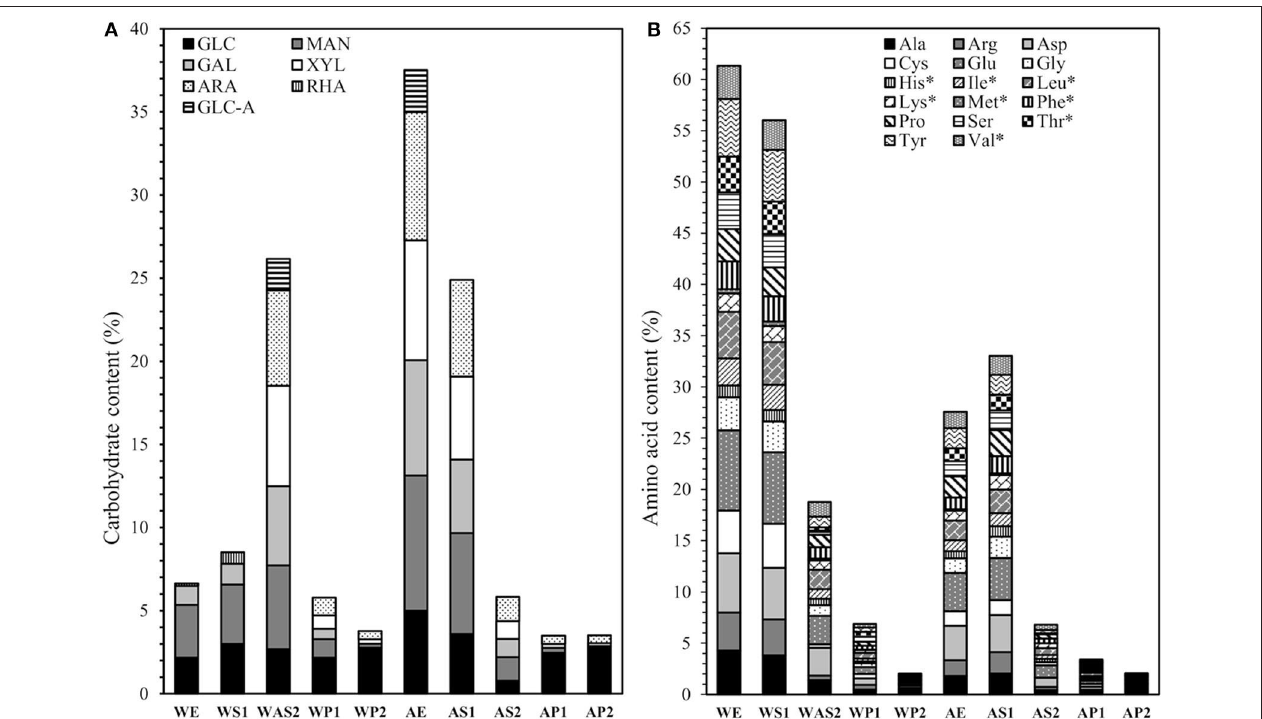
FIGURE 4 | (A) Carbohydrate composition and (B) amino acid composition of fractions extracted from biomass. Please refer to Figure 1 for the fraction codes. Essential amino acids indicated with*.